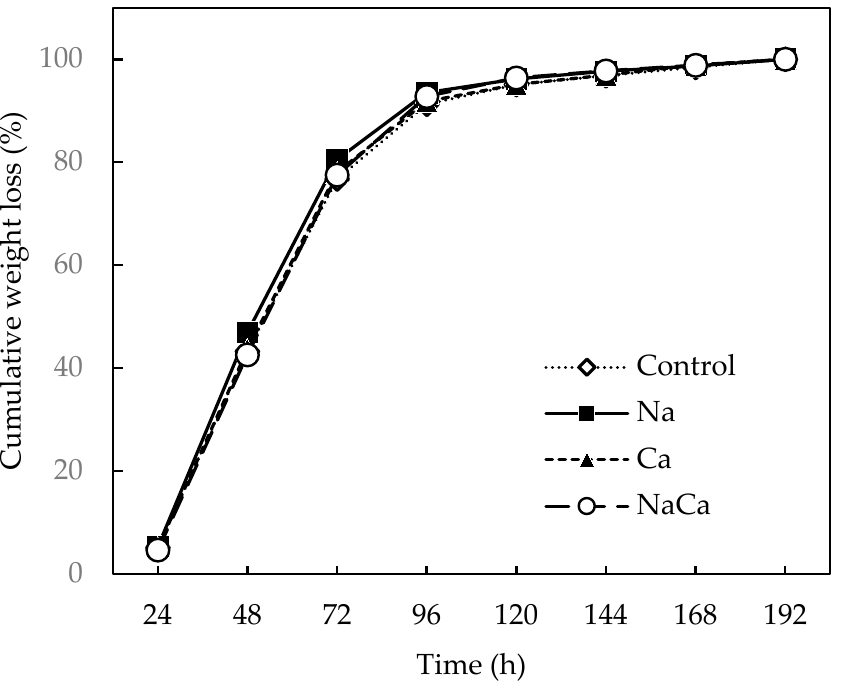
Figure 1. Fermentation progress of Pinot noir wine with or without bentonite addition, measured as ferment cumulative weight loss. Table 1. Oenological parameters and tannins measured in resultant wines.